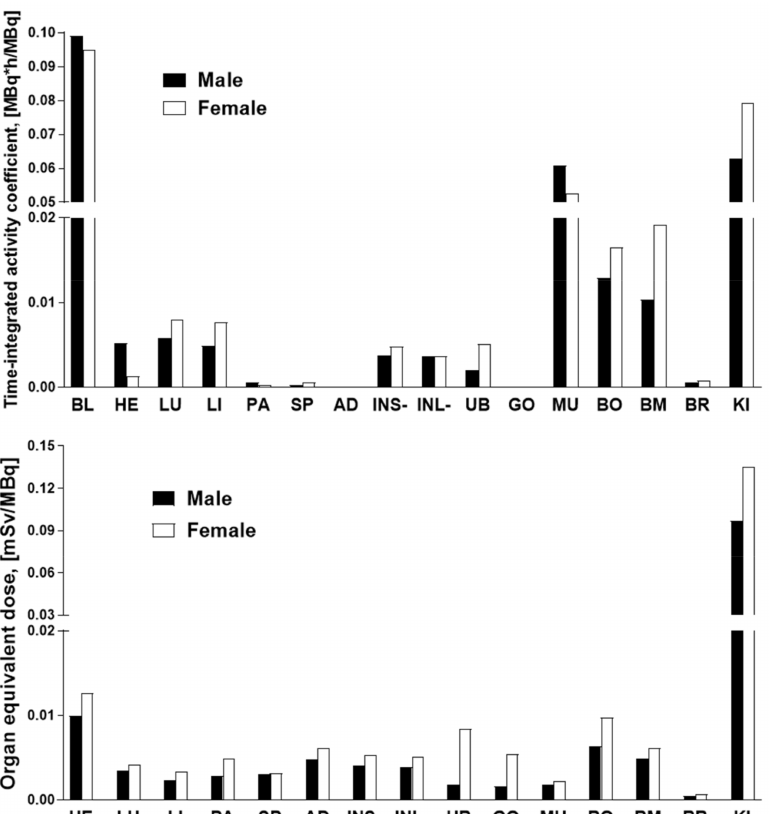
Figure 5. Graph showing the TIACs ( upper panel ) and estimated organ equivalent doses (mSv/MBq) ( lower panel ) of [ 68 Ga] Ga-NO2A-[Nle13]-Col in human females and males extrapolated from rat ex vivo organ distribution data using OLINDA/EXM 1.1 software. BL: blood; HE: heart; LU: lungs; LI: liver; PA: pancreas; SP: spleen; AD: adrenals; INS+: small intestine with its content; INL: large intestine without content; UB: bladder; GO: gonads; MU: muscle; BO: bone; BM: red bone marrow; BR: brain; KI: kidneys.